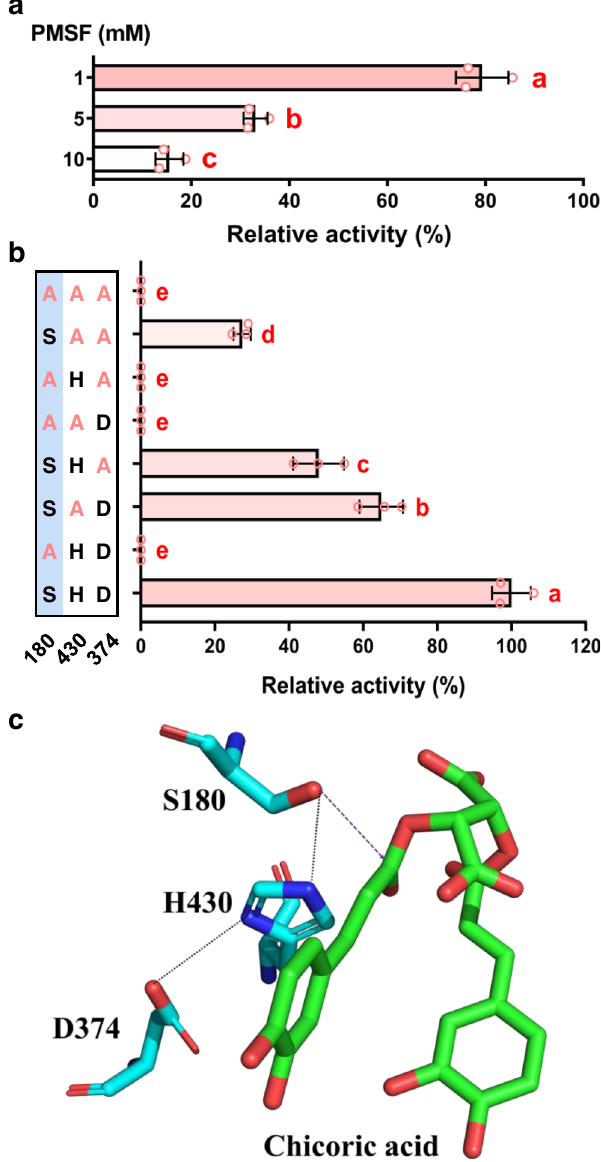
Fig. 4 The Ser-His-Asp catalytic triad is necessary for the acyltransferase activity of EpCAS. a EpCAS activity was inhibited by Phenylmethylsulfonyl fl uoride (PMSF) in a dose-dependent manner. b Site-directed mutagenesis of Ser-His-Asp catalytic triad. Ser180 is necessary for the acyltransferase activity of EpCAS. Data are mean±s.d. ( n = 3 independent experiments). Different letters in a and b indicate signi fi cantly different values at P < 0.05 analyzed by one-way ANOVA with Tukey ’ s multiple comparisons test. c Molecular docking of Ser-His-Asp catalytic triad with chicoric acid. Source data underlying a and b are provided as a Source Data fi